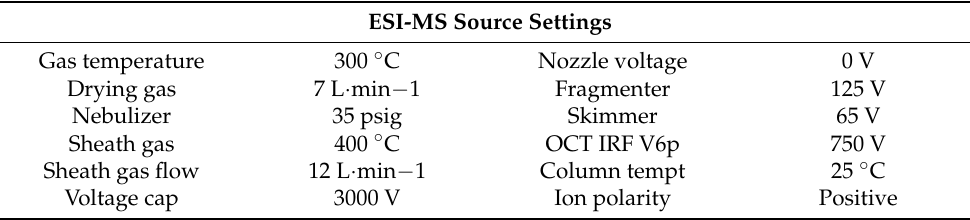
Table 2. ESI-MS settings for osmolyte analysis on an Agilent 6540 UHD Accurate Mass QToF with an InfinityLab Poroshell 120 HILIC-Z